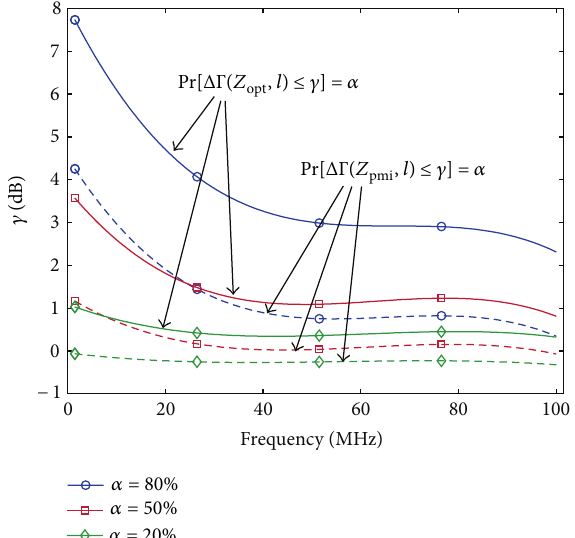
Figure 8: Best cubit fit of the SNR quantile profiles associated to the probability values 𝛼 = 20, 50 , and 80%.